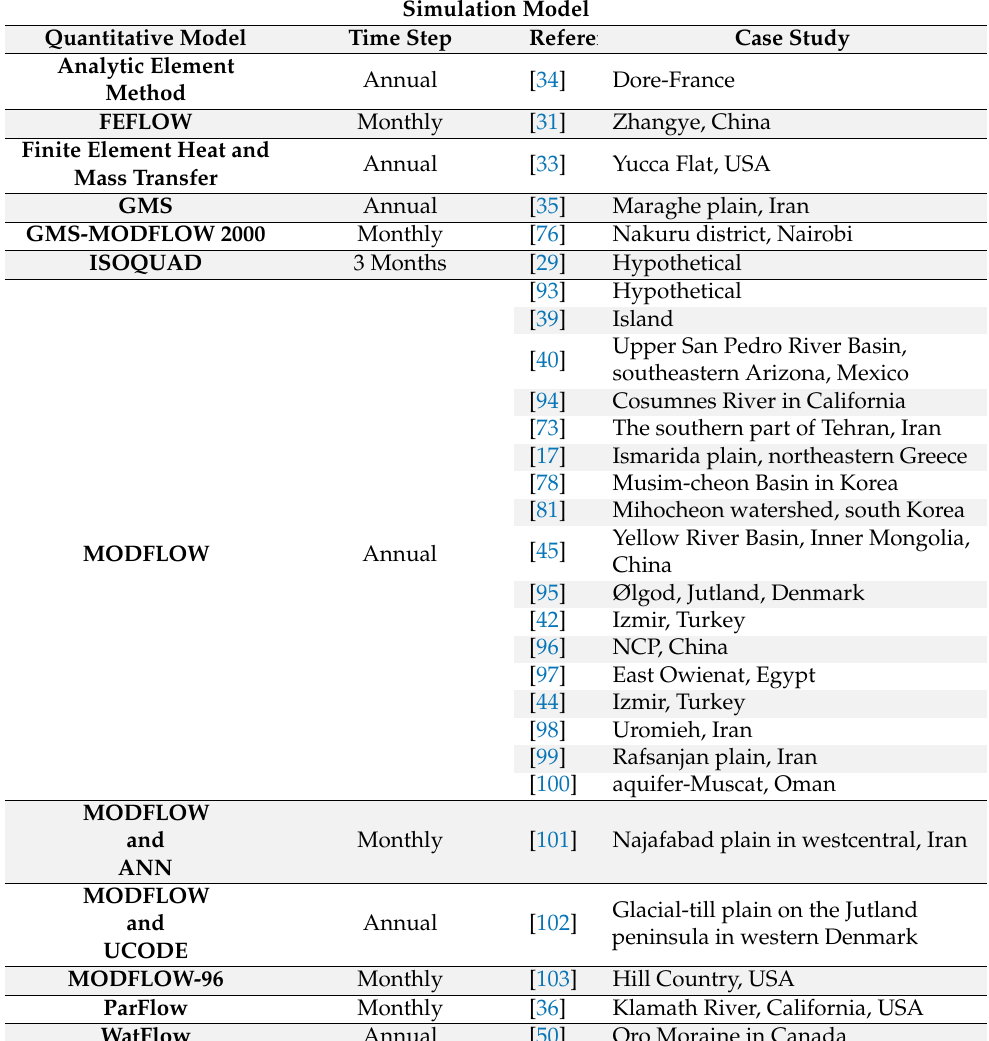
Table 2. Classification of different quantitative simulation groundwater